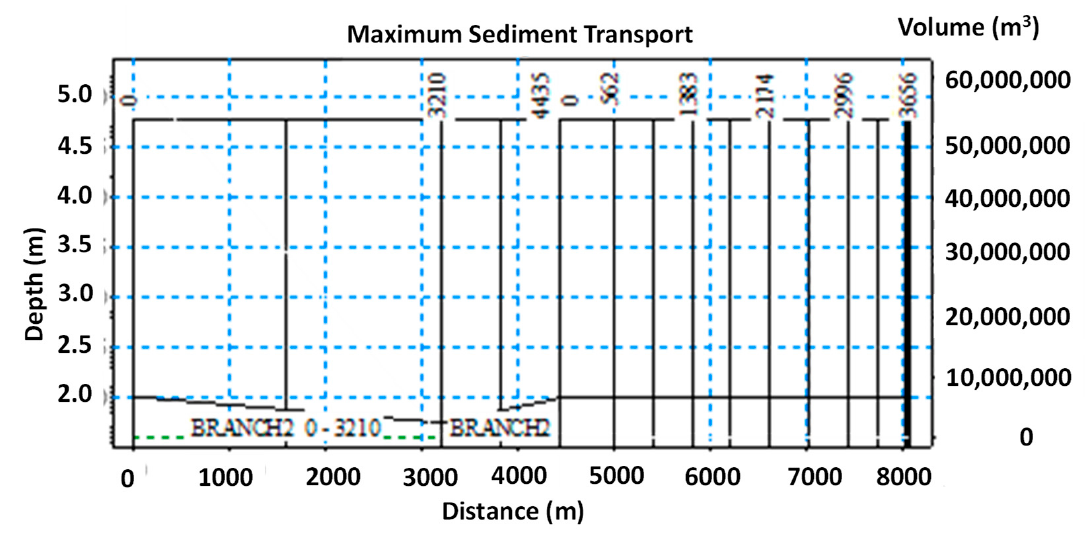
Figure 10. Sediment movement in MDC is sluicegate.